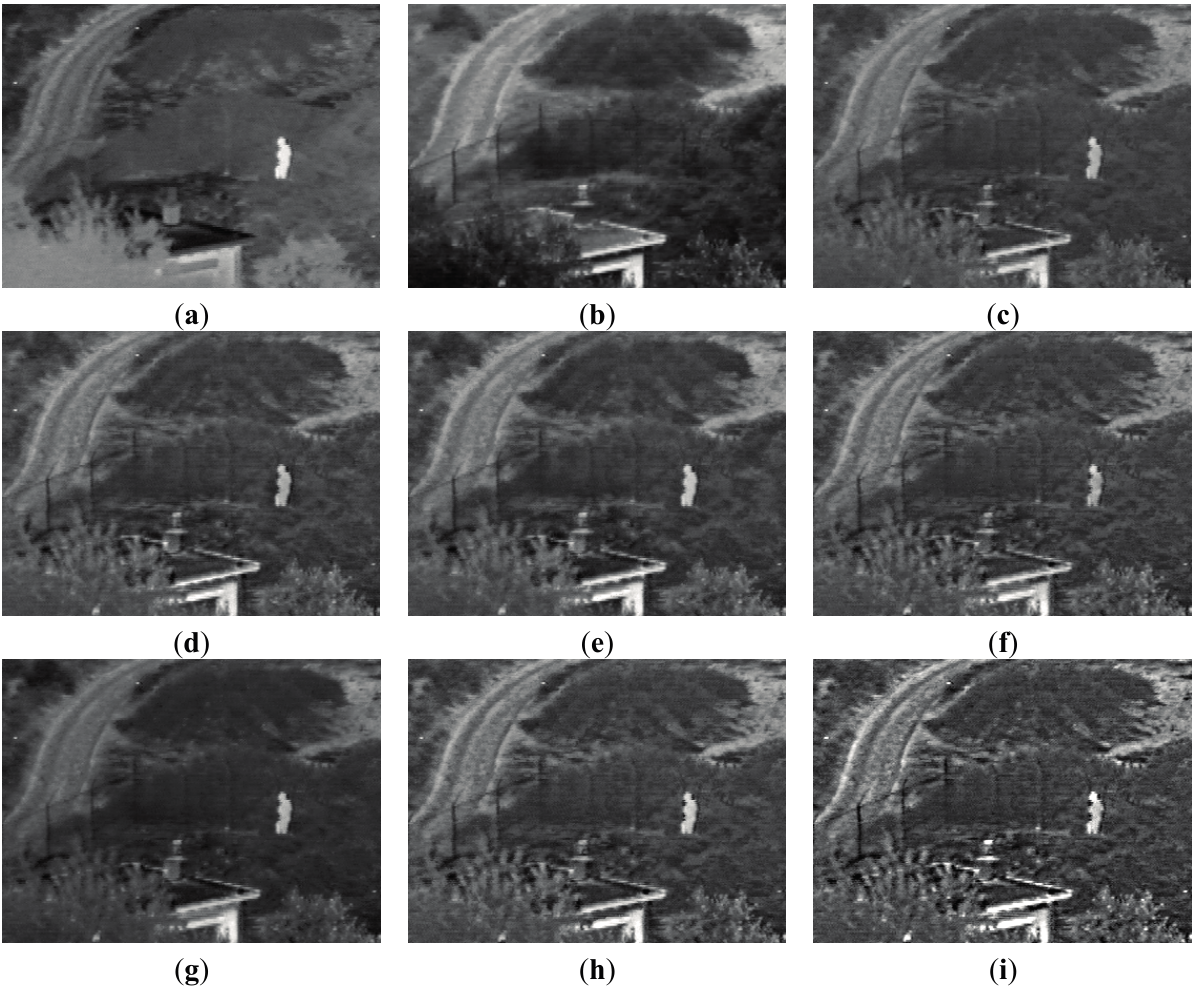
Figure 1. An example on UNcamp images. ( a ) Original infrared image ( b ) Original visual image ( c ) Result of MSTHT; ( d ) Result of SIDWT ( e ) Result of LP ( f ) Result of MSTHST; ( g ) Result of MSNTHT ( h ) Result of MSTOOC ( i ) Result of the proposed